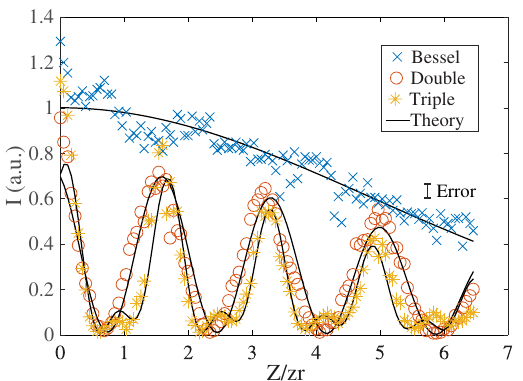
3 Scientific RepoRts | 7: 17 | DOI:10.1038/s41598-017-00042-w